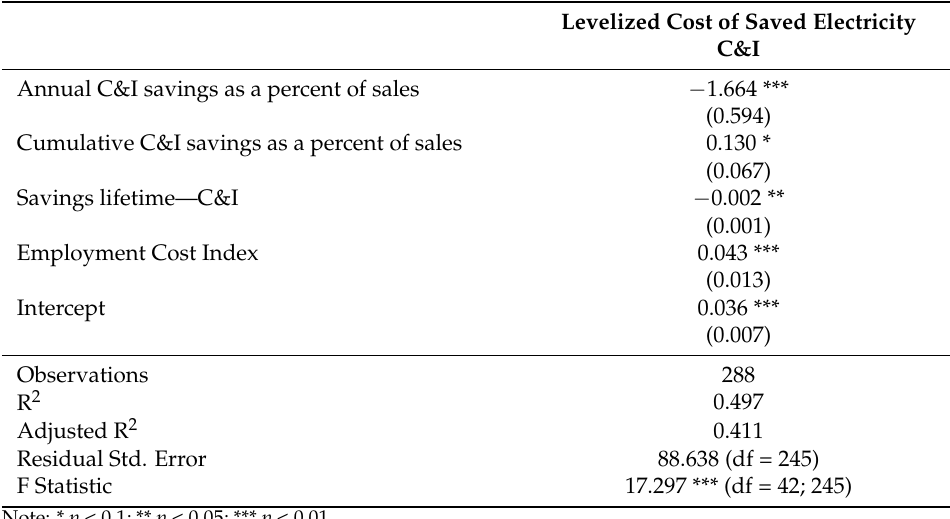
Table A2. Regression results for C&I programs only.